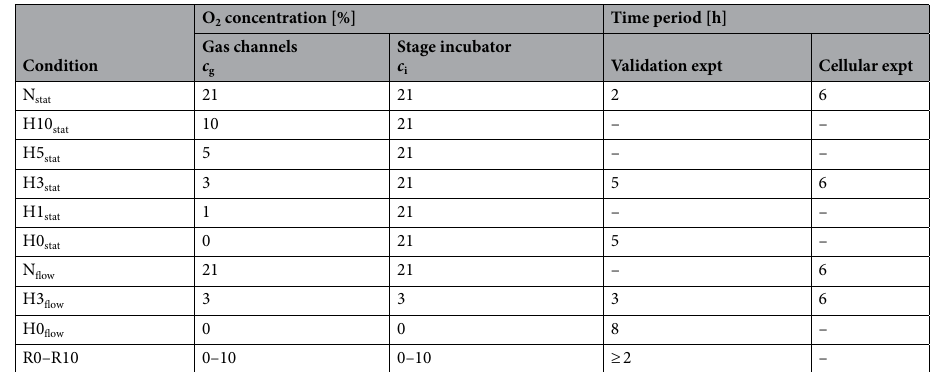
ratio between convection and diffusion: